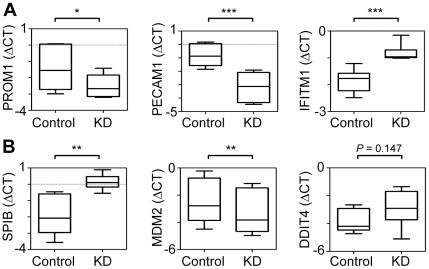
Validation of selected differentially expressed genes from the KD experiments by RT-qPCR.Quantification of transcripts of differentially expressed genes. A: Concordantly de-regulated by E/R in the KD and primary leukemias. B: Only regulated in the KD experiments. Boxes cover the median and the interquartile range (25–75th percentiles) and whiskers the minimum and maximum values. *, P≤0.05; **, P≤0.01; ***, P≤0.001 (paired t-test).